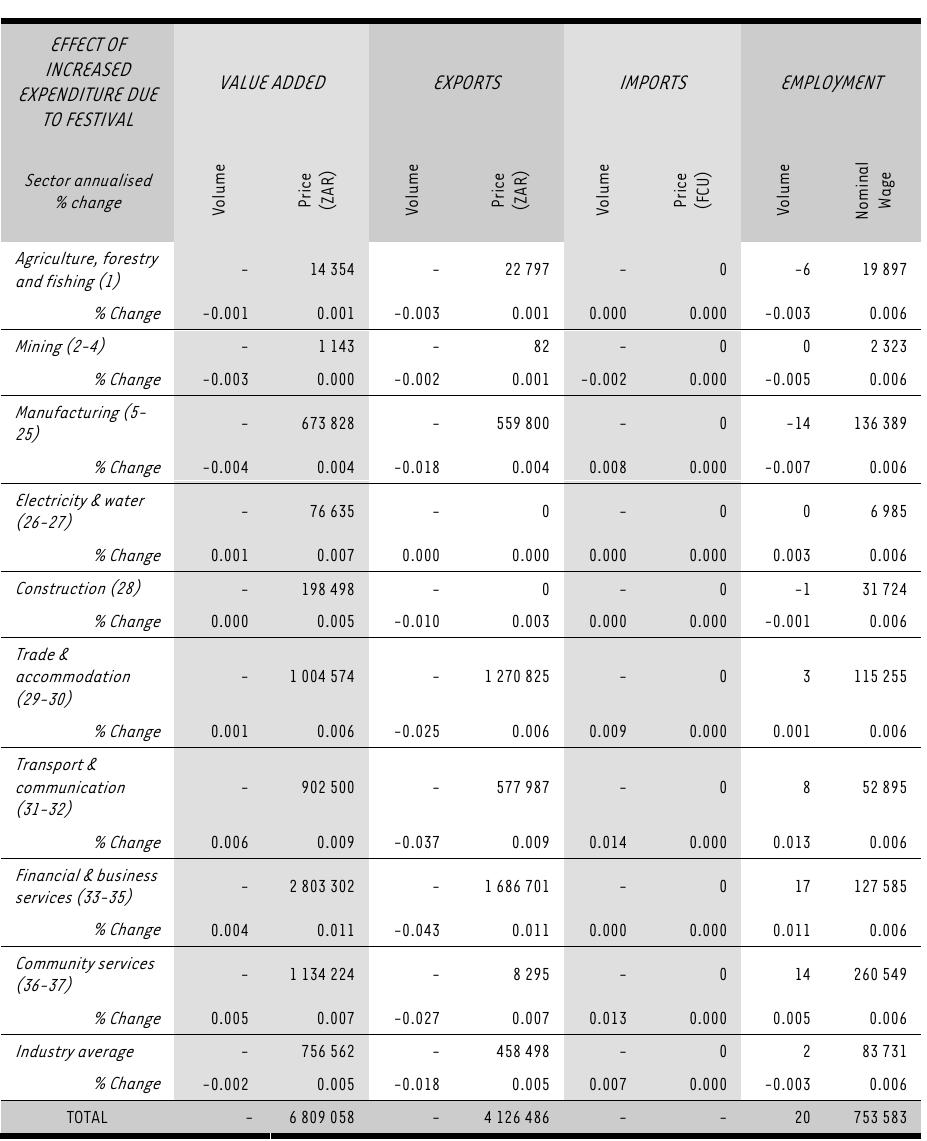
TABLE 11: Aggregate sectoral level impacts (structural effects for the regional model only) – rest of South